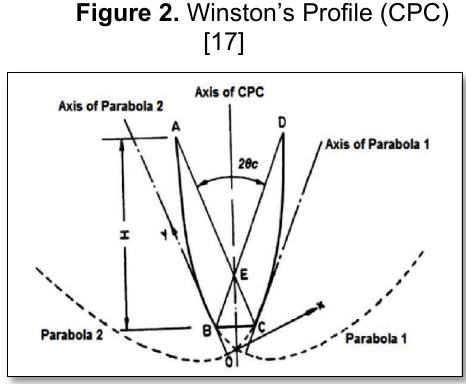
Figure 4. The actual CPC with dimensions (All dimensions are in mm)